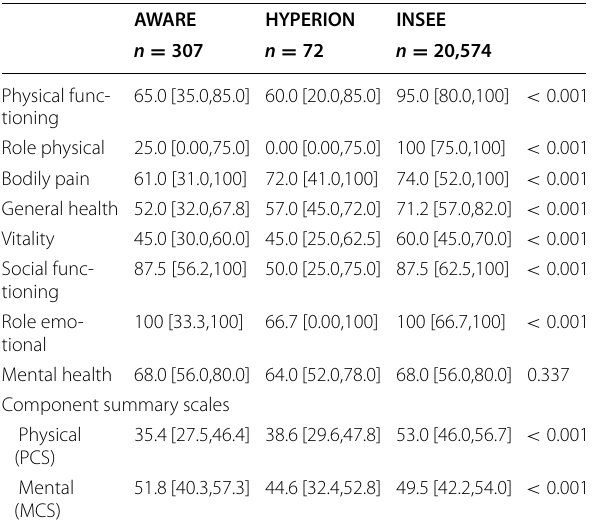
Table 3 Factors associated with physical and mental component scores. Multivariable linear regression Coefficient( 95% conf.